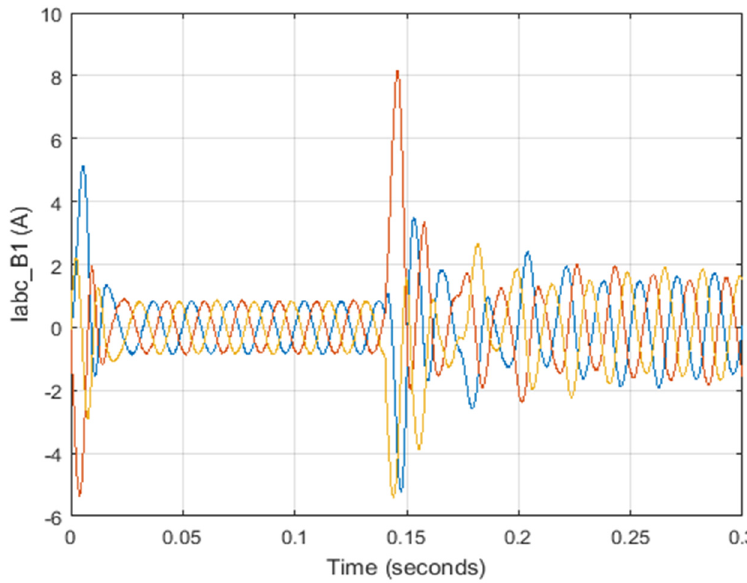
Figure 21. Common point (common base) grid and microgrid current.